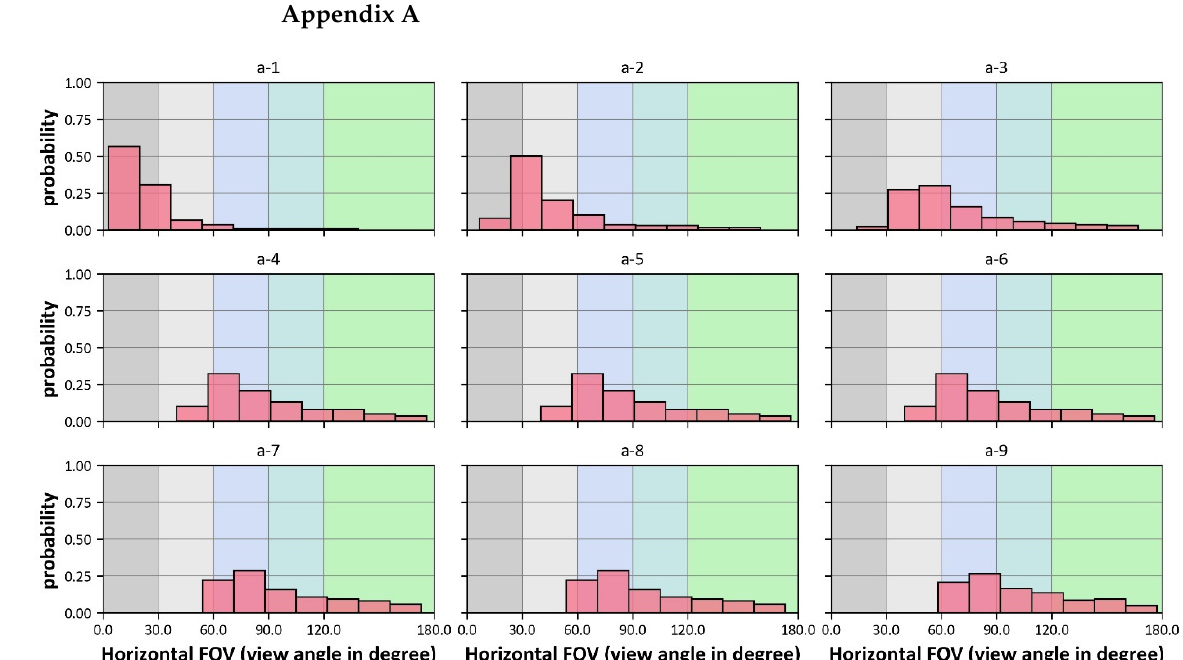
Figure A1. Histograms of the computed horizontal FOVs for scenario-a, including case studies with different window sizes.